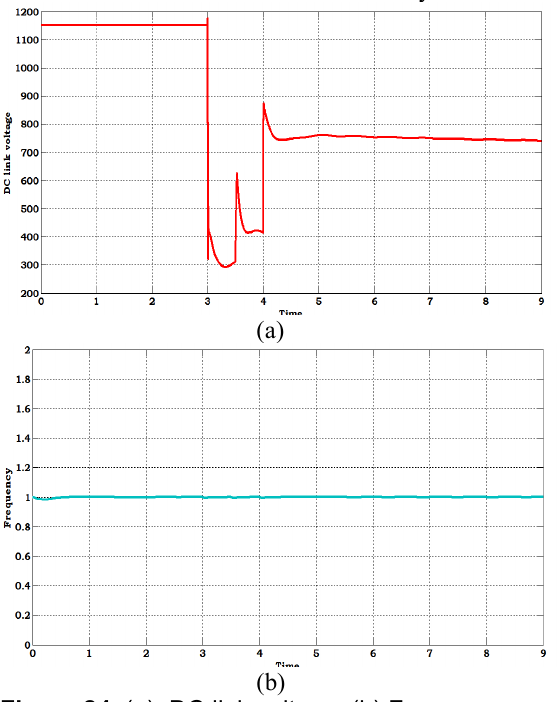
Figure 24. (a). DC link voltage, (b).Frequency There is sudden change in DC link voltage at t=3 sec but controller brings back voltage and frequency in constant. Test Case 3: when operating system in grid connected mode with sudden connection of other units.